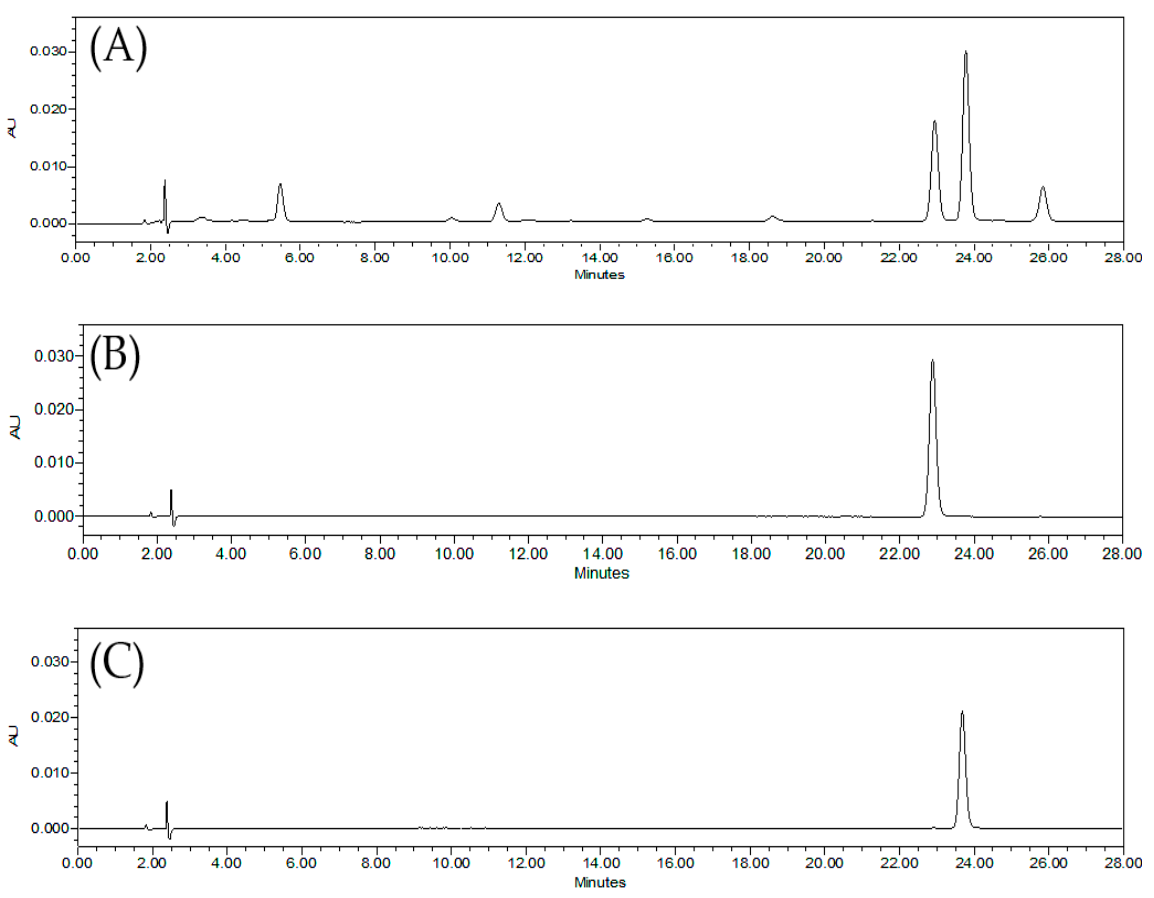
Figure 3. High-performance liquid chromatography chromatograms of ( A ) Vaccinium bracteatum Thunb. (VB) extract sample, ( B ) orientin, ( C ) isoorientin.